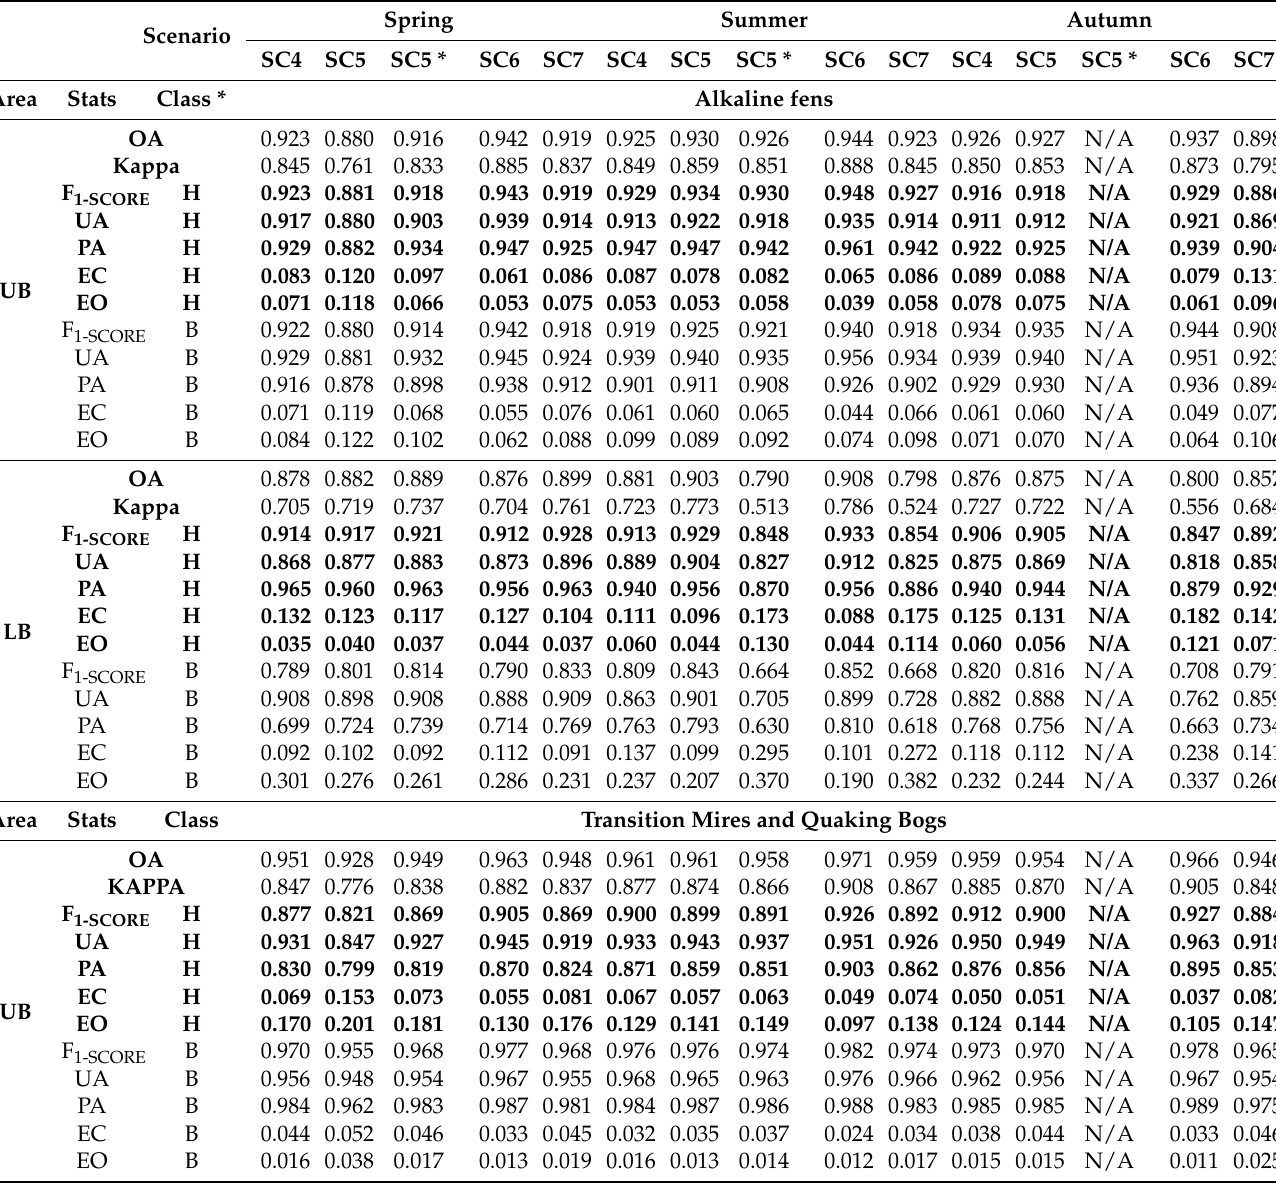
Table 4. Results of multi-classification (50 classifications per scenario) on randomly selected botanical reference data for wetland habitats in the UB, LB and JF areas in scenarios from 4 to